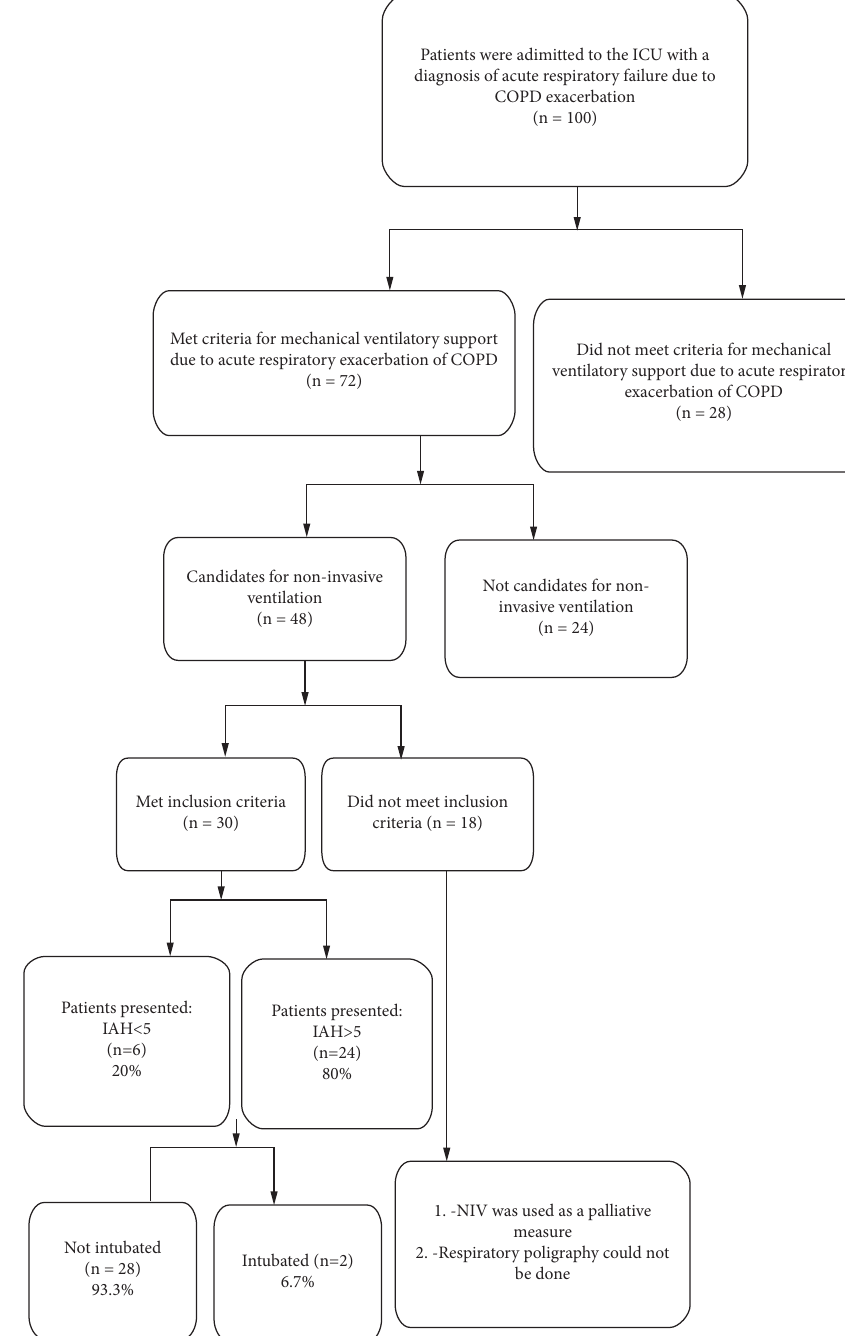
Figure 1: Flow chart of selection and presentation of